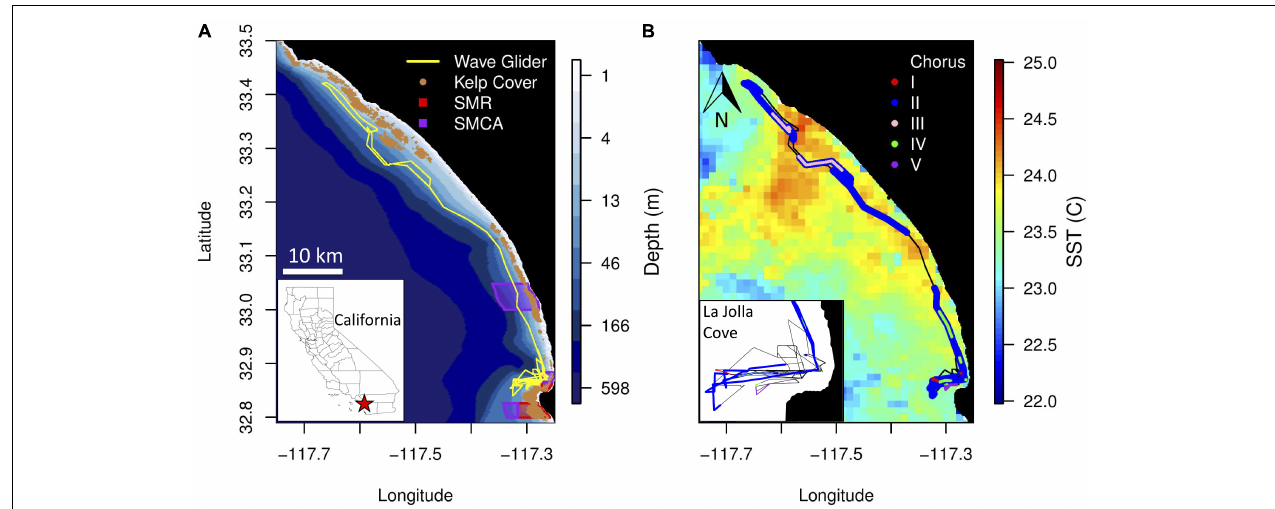
FIGURE 2 | (A) Bathymetry along the Wave Glider track (yellow line) from La Jolla Cove, San Diego, to Capistrano Beach, CA. Historical kelp cover is shown in brown. California State Marine Reserves (SMR) and State Marine Conservation Areas (SMCA) within the study area are shown in red and purple, respectively. (B) Average sea surface temperature ( ◦ C) during the Wave Glider deployment. The locations where the five fish choruses were recorded are shown in red (Type I), blue (Type II), light pink (Type III), green (Type IV) and purple (Type V). Each chorus is mapped separately in Supplementary Figure S1 . (Inset) Zoomed in view of the location of the fish choruses recorded near La Jolla Cove.